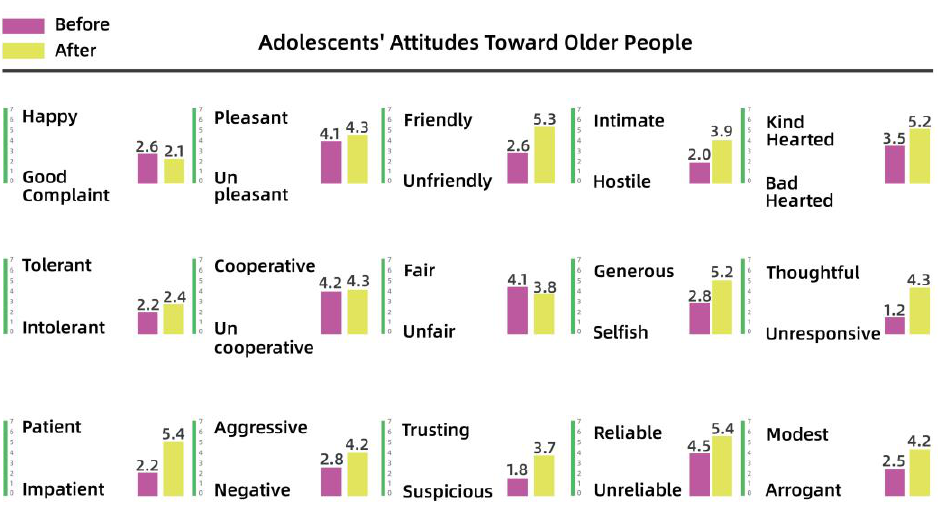
Figure 9. Adolescents’ attitudes toward older people.